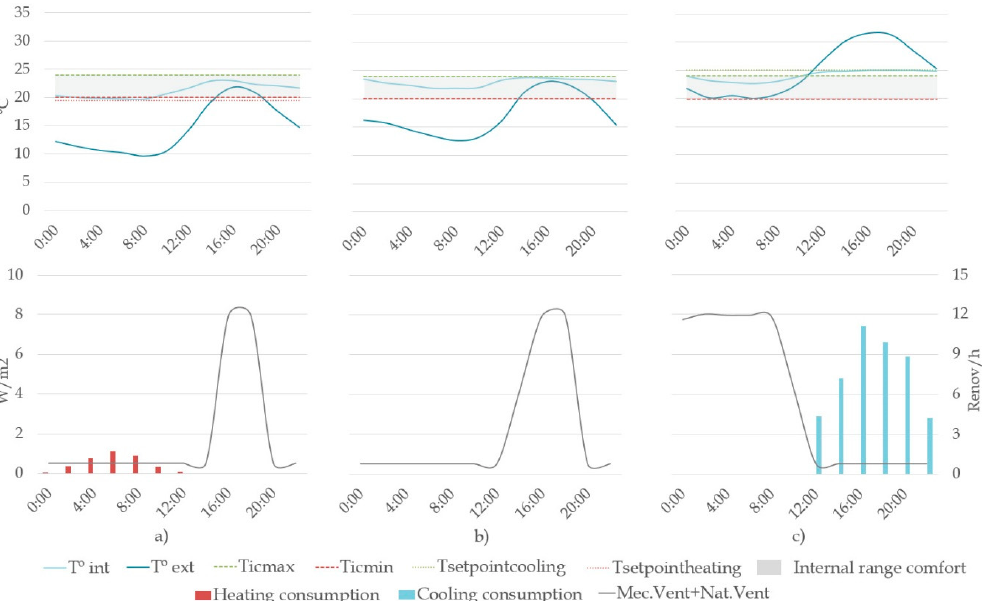
Figure 7. Daily energy consumption in the historical scenario: ( a ) Typical day in January; ( b ) Typical day in April; ( c ) Typical day in July.